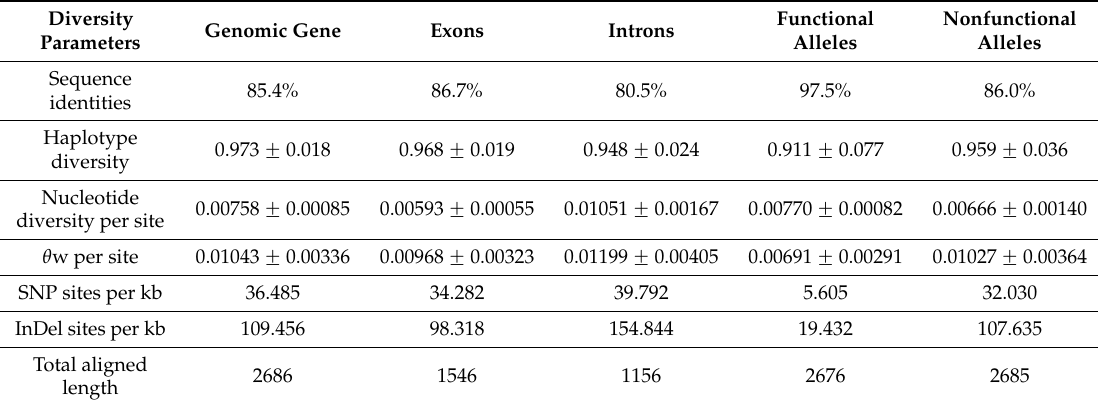
Table 3. Genetic diversity in AtTGG6 alleles in 29 Arabidopsis thaliana